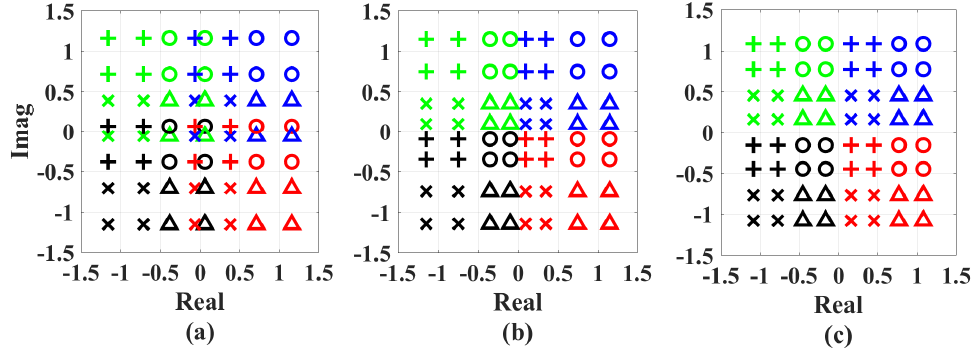
Figure 5. The SCs of ( a ) the no adjustment scheme, ( b ) the SC-A scheme and ( c ) the SC-SIC-A scheme. The parameters of ( b , c ) are obtained, when K = 3 and γ 1 = 21 dB. Colours are used to distinguish the data of user 1, and markers are used to distinguish the data of user 2 when user 1’s data are